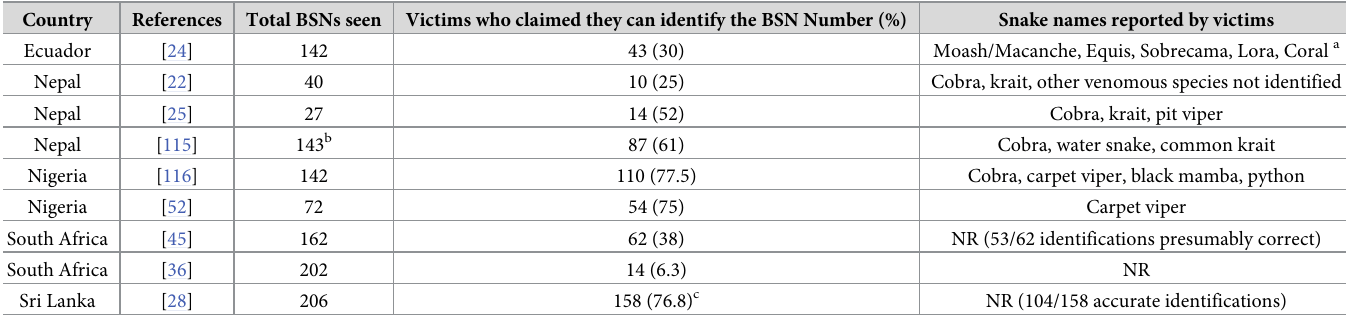
Table 4. BSN identifications done by